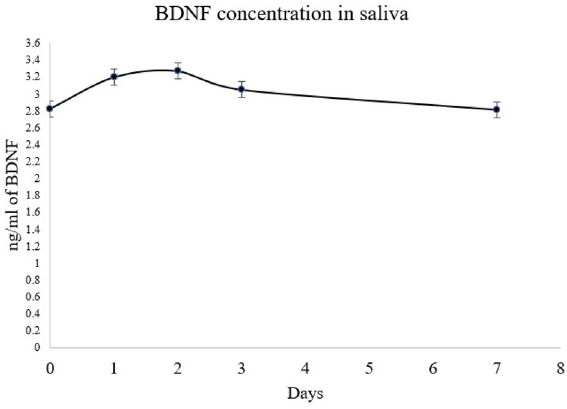
Figure 4. BDNF concentration among the patients at different time interval.